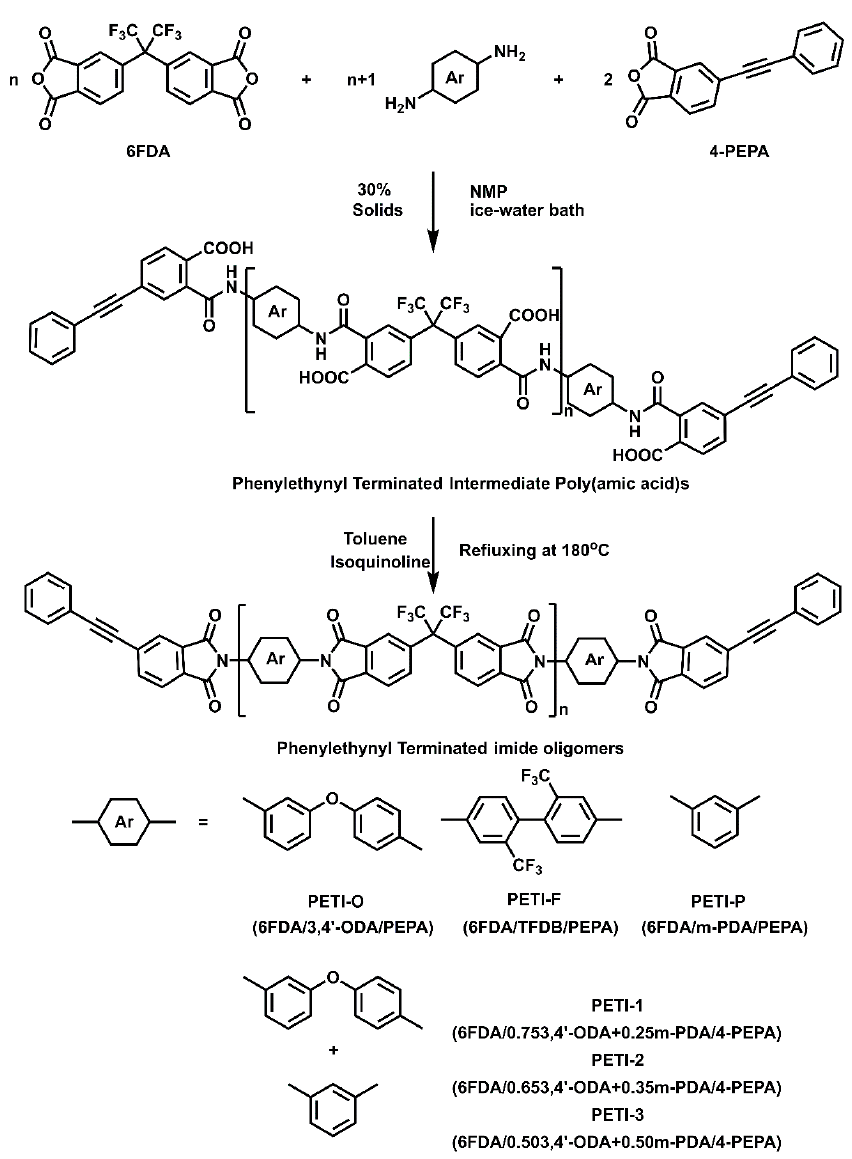
Scheme 2. Synthesis of fluorinated phenylethynyl-endcapped polyimides.